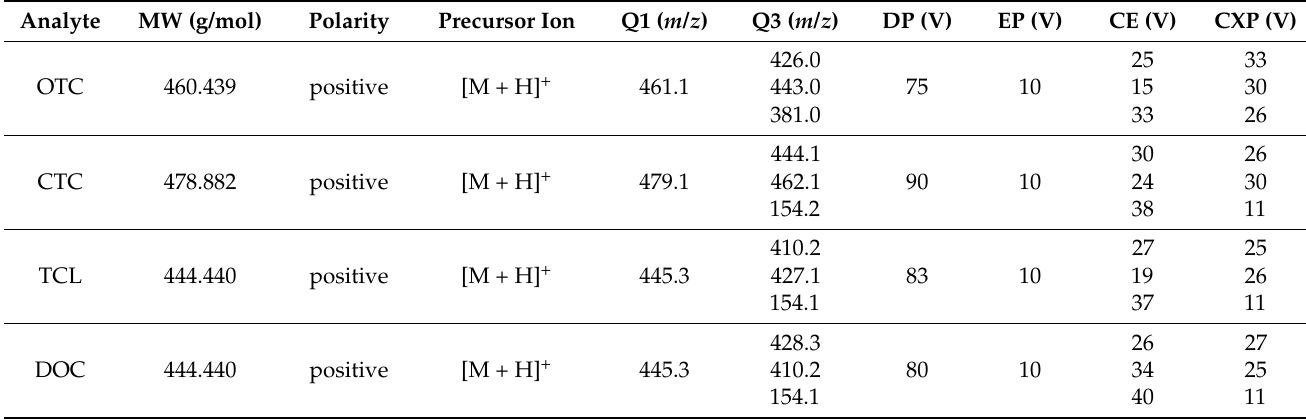
Table 2. Multiple Reaction Monitoring (MRM) transitions and optimized MS parameters for TCLs. OTC = oxytetracycline, CTC = chlortetracycline, TCL = tetracycline, DOC = doxycycline, EOTC = oxytetracycline, ECTC = epichlortetracycline, ETCL = epitetracycline, MEC =